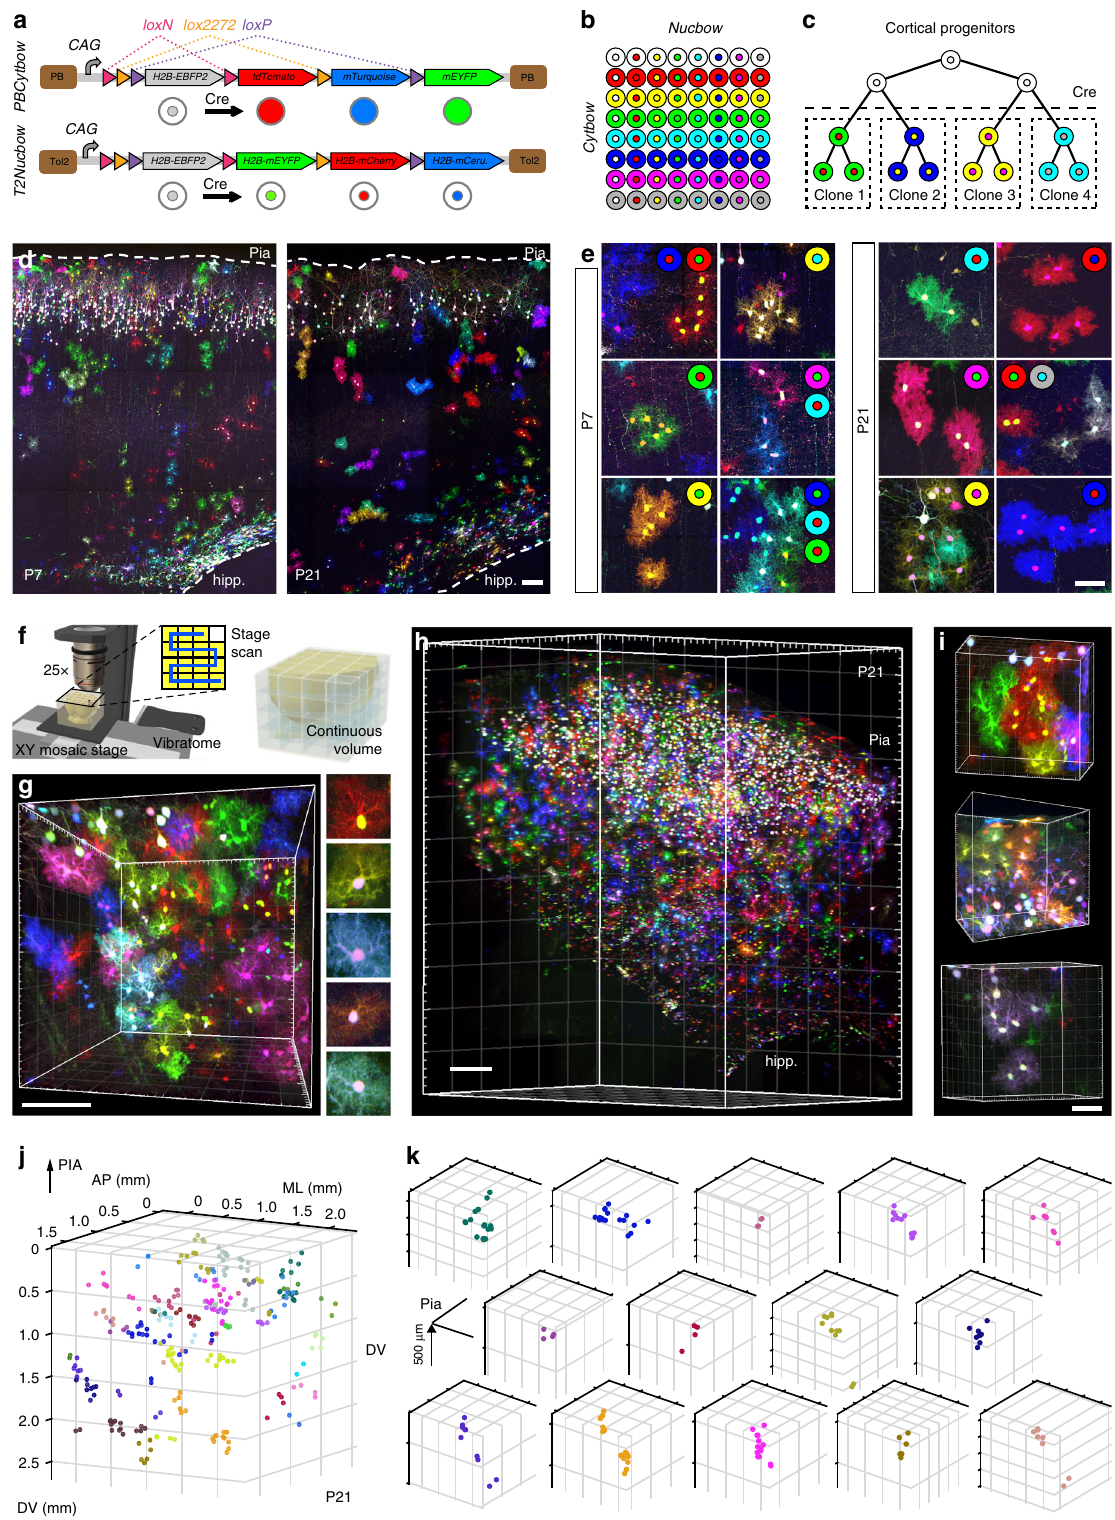
the volume of individual astrocyte domains, Fig. 2d, e, Supple- mentary Fig. 2e, f), and there was hence signi fi cant intermixing with cells of neighboring clones. The spatial arrangement and volume of the clones were highly variable, at P7 as well as P21 (Fig. 2d, e, Supplementary Fig. 2f, g, also see Supplementary